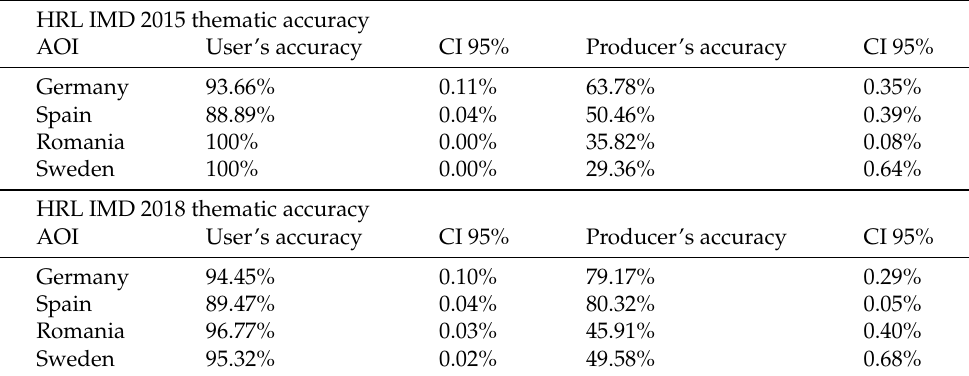
Table 2. EEA validation results provided for the IMD 100 m product imperviousness class (30 percent threshold) for the blind approach. Adapted from [29,30].